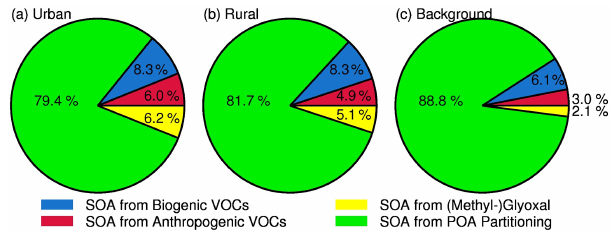
Figure 14. NT-SOA module simulated contributions of different formation pathways to SOA levels averaged over the simulation episode at (a) urban, (b) rural, and (c) background sites.